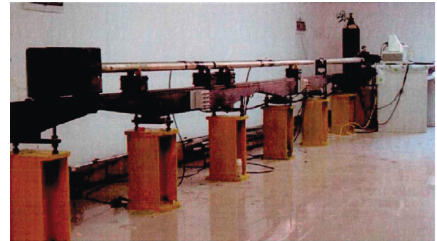
Figure 2: SHPB loading device.